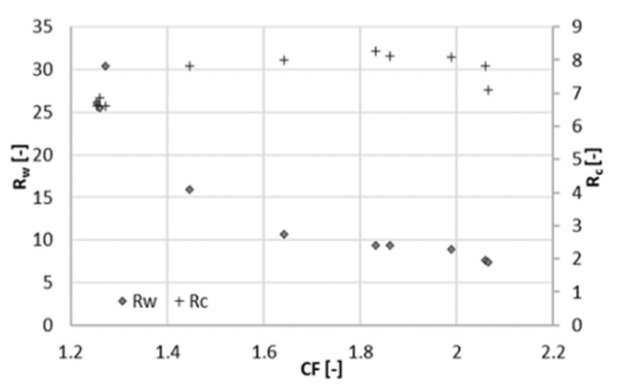
Figure 7. Concentration ratio ( R c ) and mass ratio ( R w ) at different concentration factors CF (25